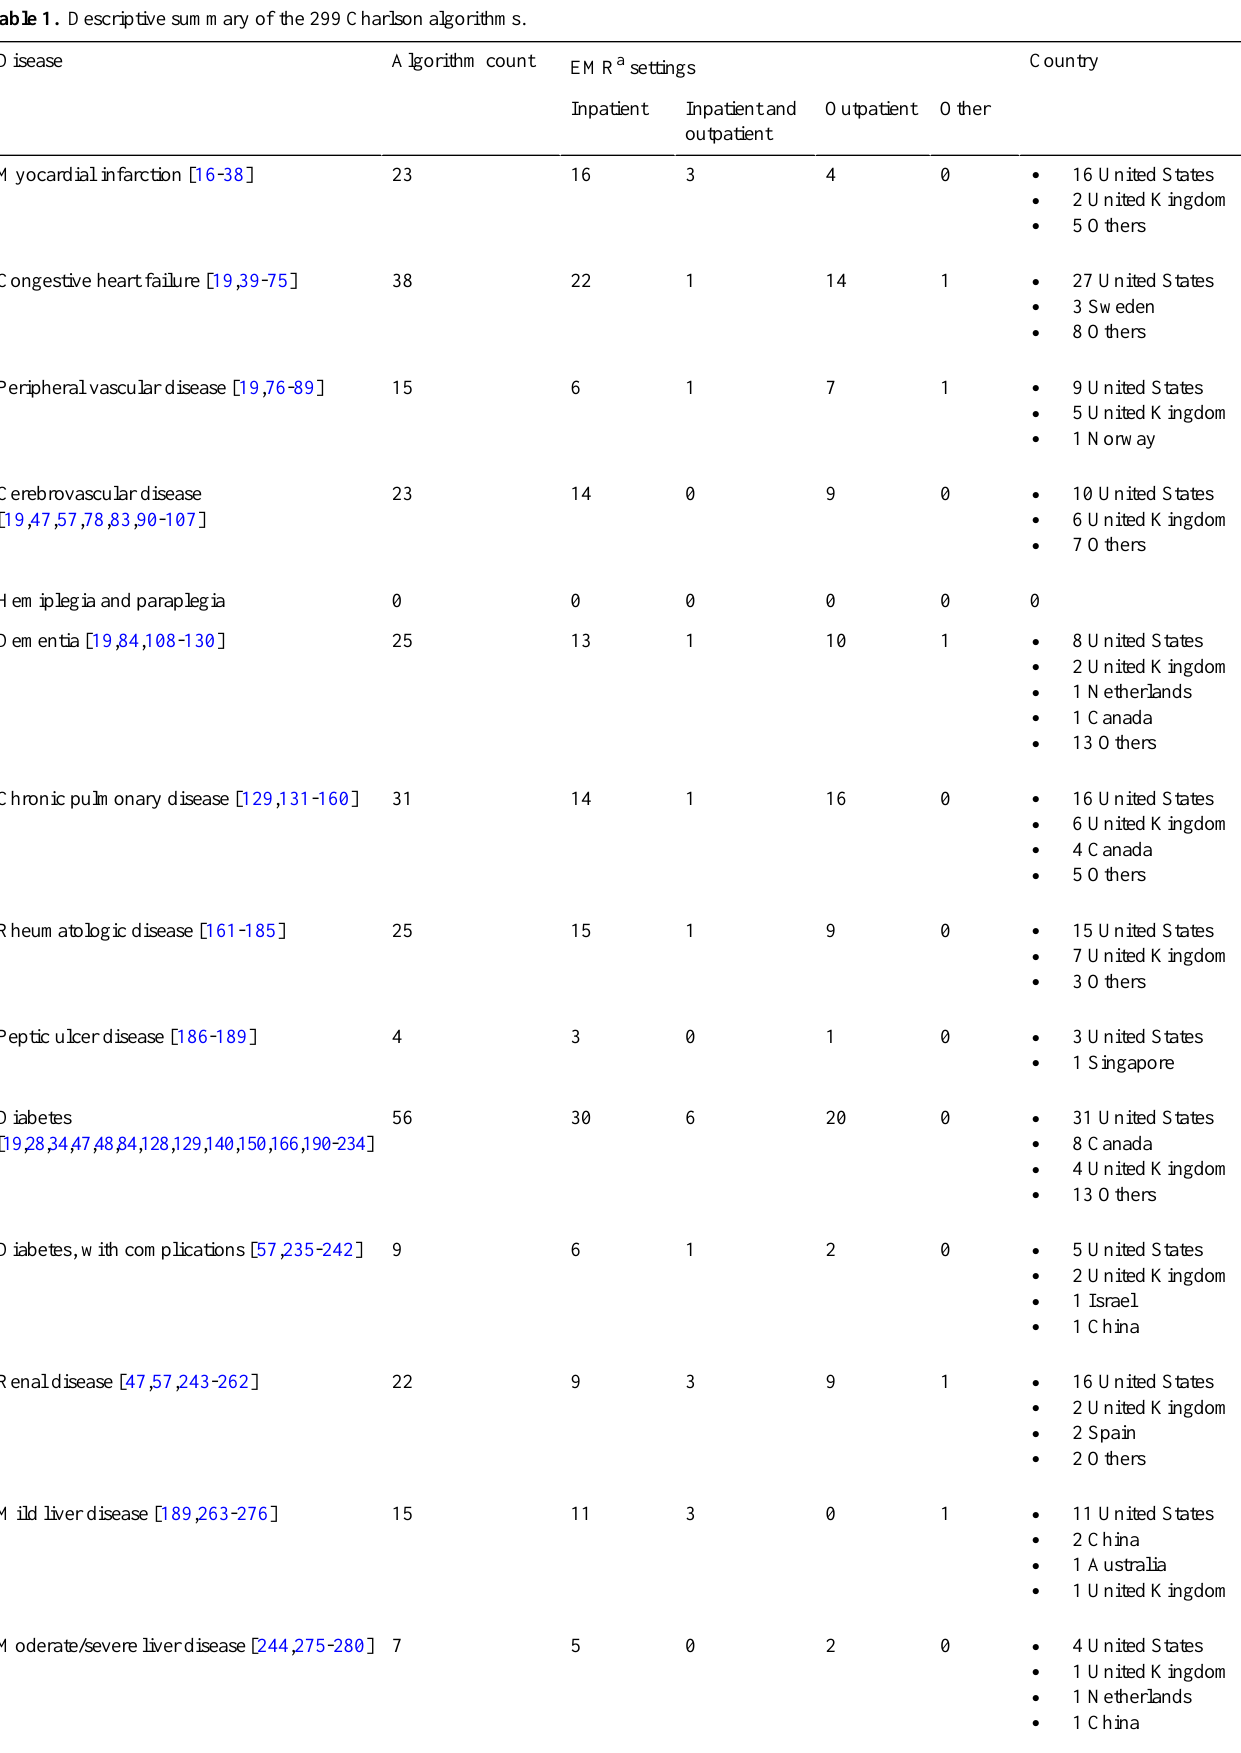
Table 1. Descriptive summary of the 299 Charlson